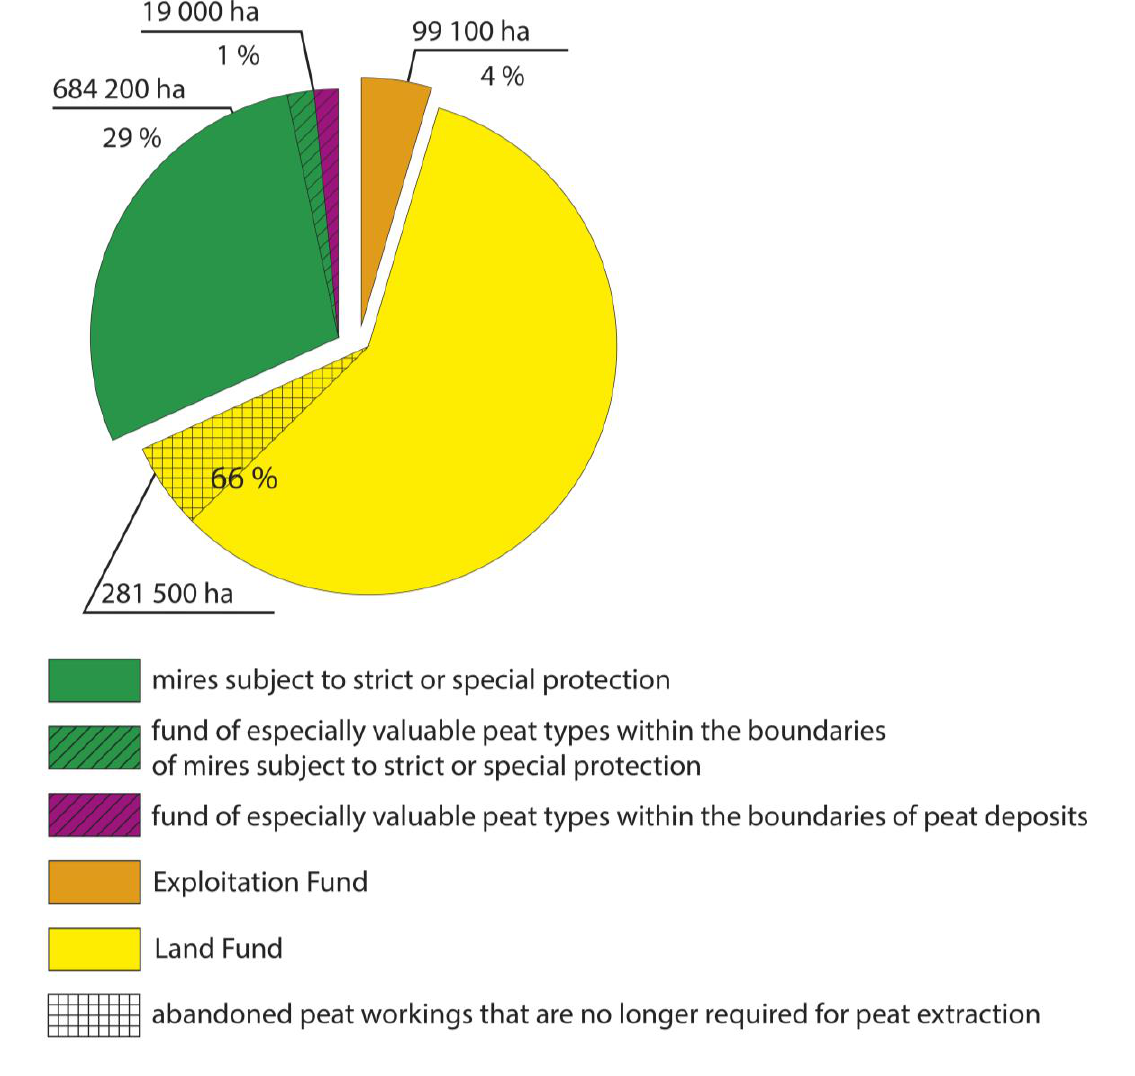
Figure 6. Summary of the allocation of Belarussian peatlands amongst the land funds, according to the ‘Scheme until 2030’. See also Table A2.3 (in Appendix